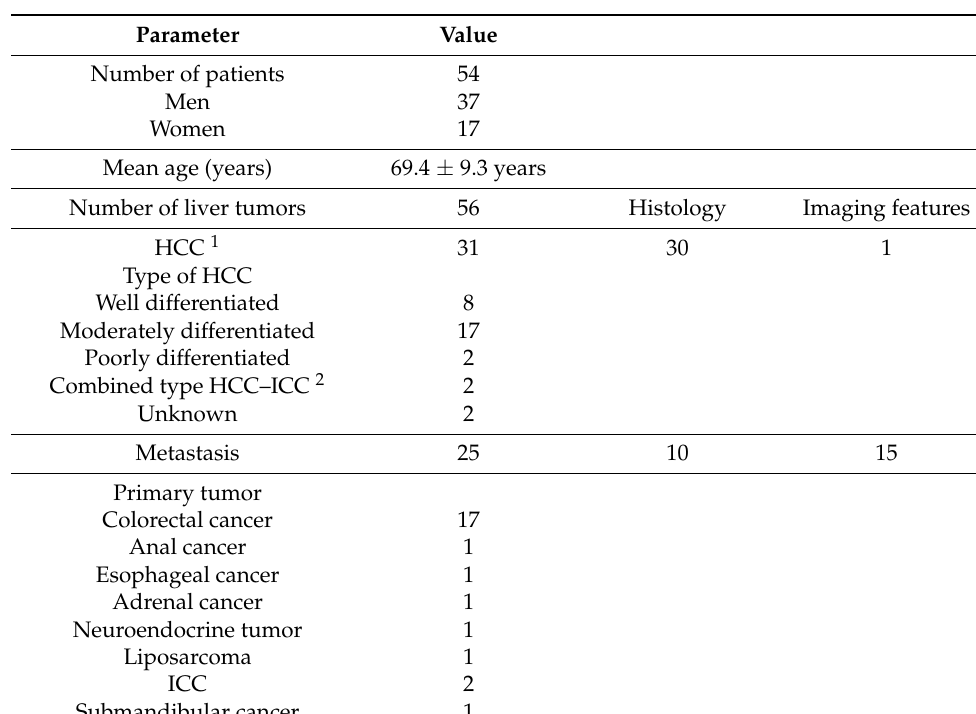
Figure 1. Flowchart of the patient enrollment process. Table 1. Patient